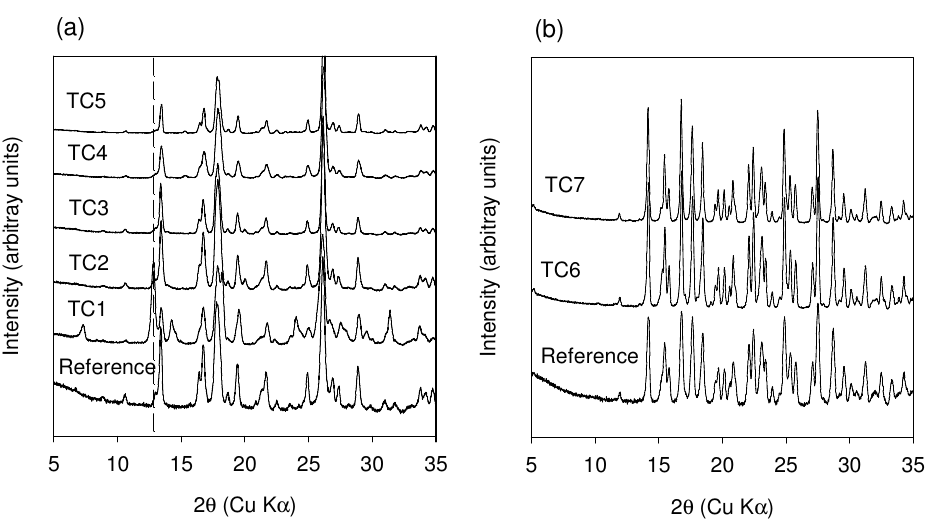
Figure 10. XRPD of materials obtained from the extrusion of Theophylline and citric acid. The descriptions of samples TC1 through TC7 are provided in Table 2. ( a ) Samples producing the anhydrous cocrystal phase; and ( b ) samples producing the hydrated cocrystal. The dotted line in Figure (a) tracks the peak at 12.8° 2 θ and provides information about unreacted starting material in the extruded samples.